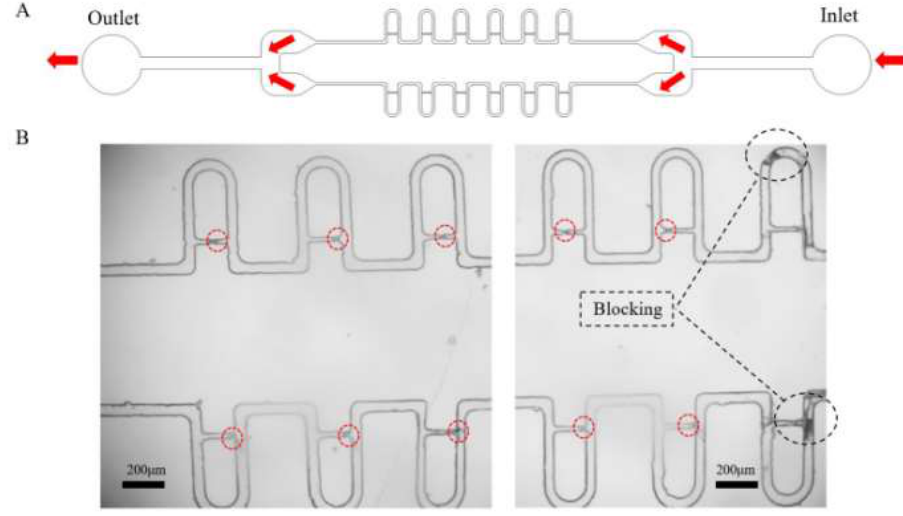
Figure 5. ( A ) The illustrations of the capture chip with 12 trapping cavities. ( B ) Microscopic image of single live tobacco protoplasts trapped in the cavities.